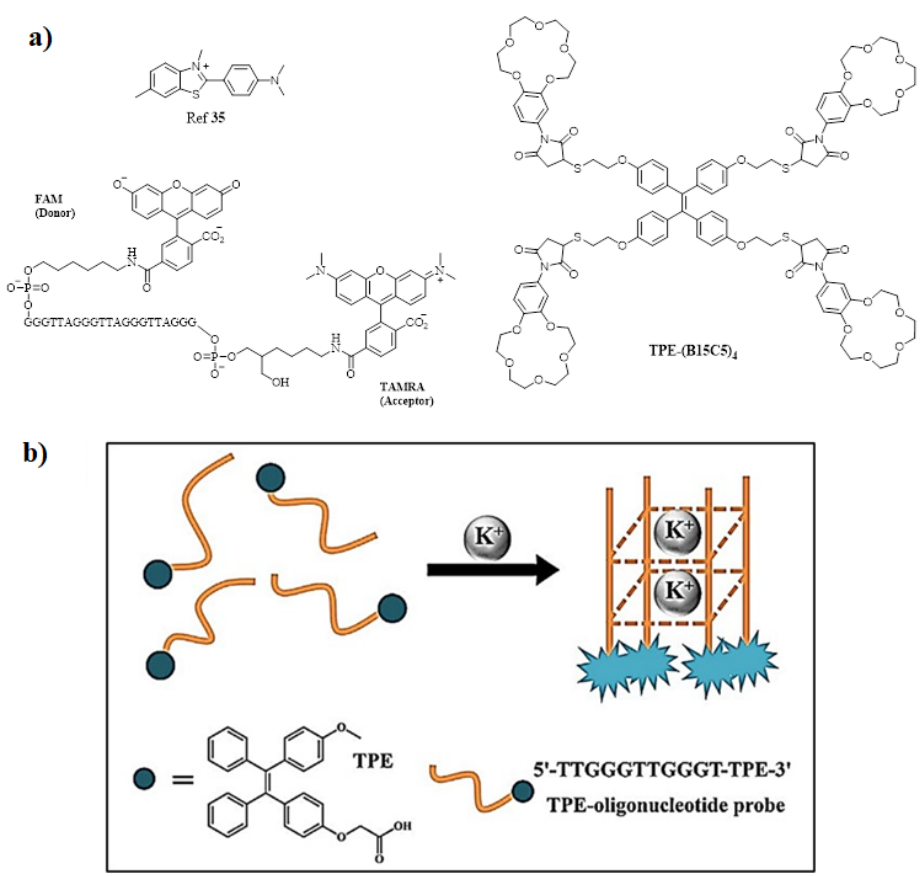
Figure 4. ( a ) Structural illustration of the synthesized AIE active fluorescent molecules for sensing of K + [38] ( b ) tetraphenylethyne (TPE) modified DNA oligonucleotide used for sensing of K + . Reprinted from reference [36] with the permission of Elsevier.